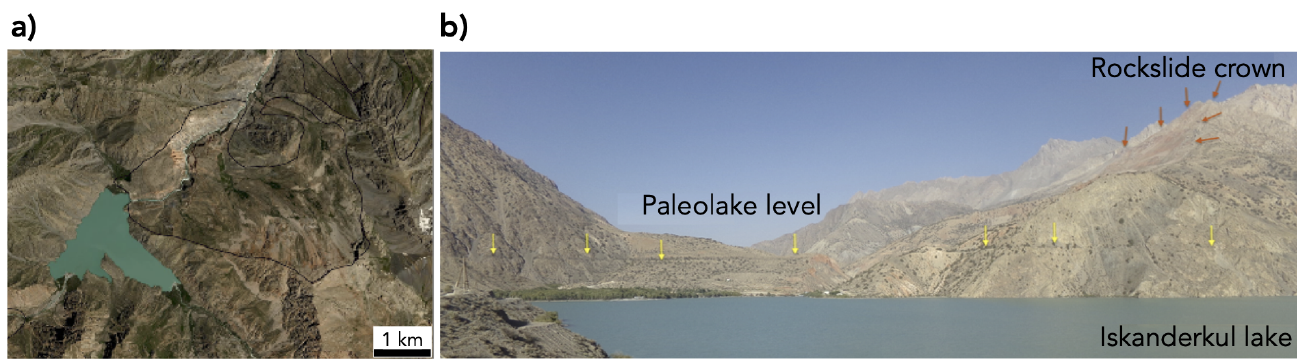
Figure 2. Iskander lake. ( a ) Google Earth view of the Iskander lake dammed by a rockslide. Black polygons correspond to the landslide catalogue. ( b ) Field view of the Iskander lake dam. Rockslide crown highlighted by red arrows; paleolake level, marked by yellow arrows, represent the maximum lake level before the dam incision